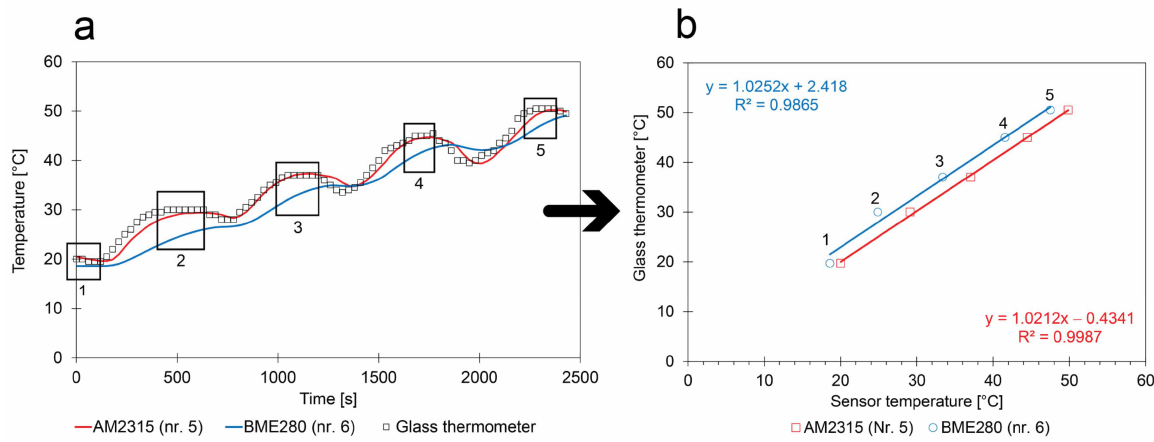
Figure 9. The heating experiment was repeated in Belgium (moderate marine climate) with two different sensors; ( a ) raw data with periods in the rectangles where the glass thermometer shows constant values; ( b ) calibration curve obtained by processing the raw data in the